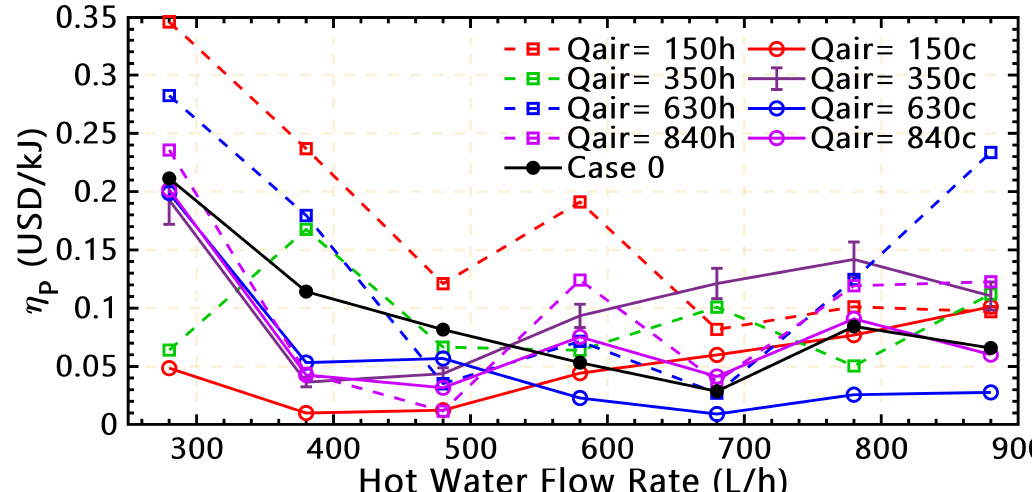
Figure 14. 𝜂 (cid:3017) vs. hot water flow rate at different operating conditions. Figure 14. η P vs. hot water flow rate at different operating conditions.